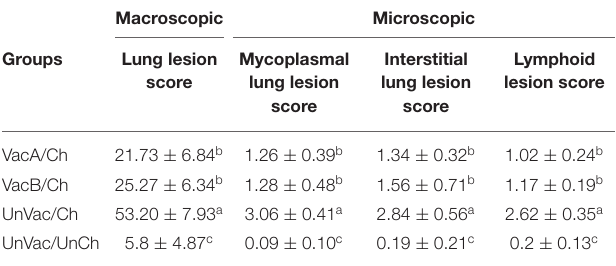
TABLE 3 | Lung and lymphoid lesion scores in pigs from different groups. Macroscopic Microscopic Groups Lung lesion Mycoplasmal Interstitial score lung lesion lung lesion score